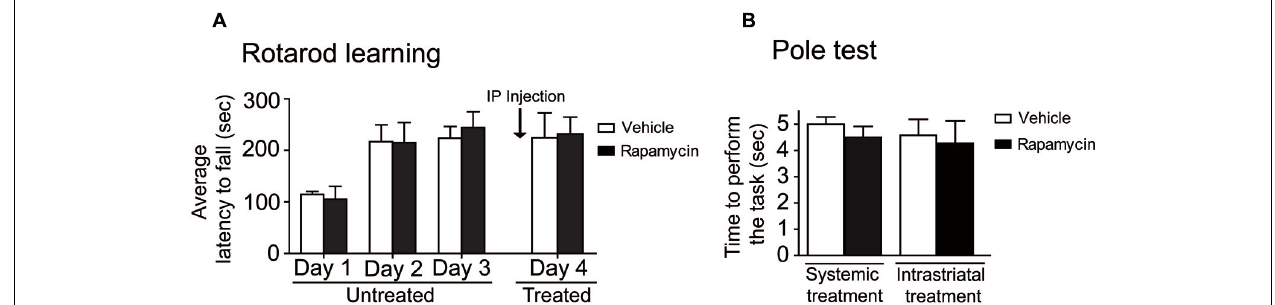
FIGURE 4 | Motor abilities are not affected in mice after mTOR inhibitions. (A) Mice were trained on the accelerating rotarod during 4 days. At day 4, mice were systemically injected with either vehicle (DMSO) or rapamycin. Data represent the average mean latency to fall expressed in seconds from 10 assays per training day ± S.E.M,